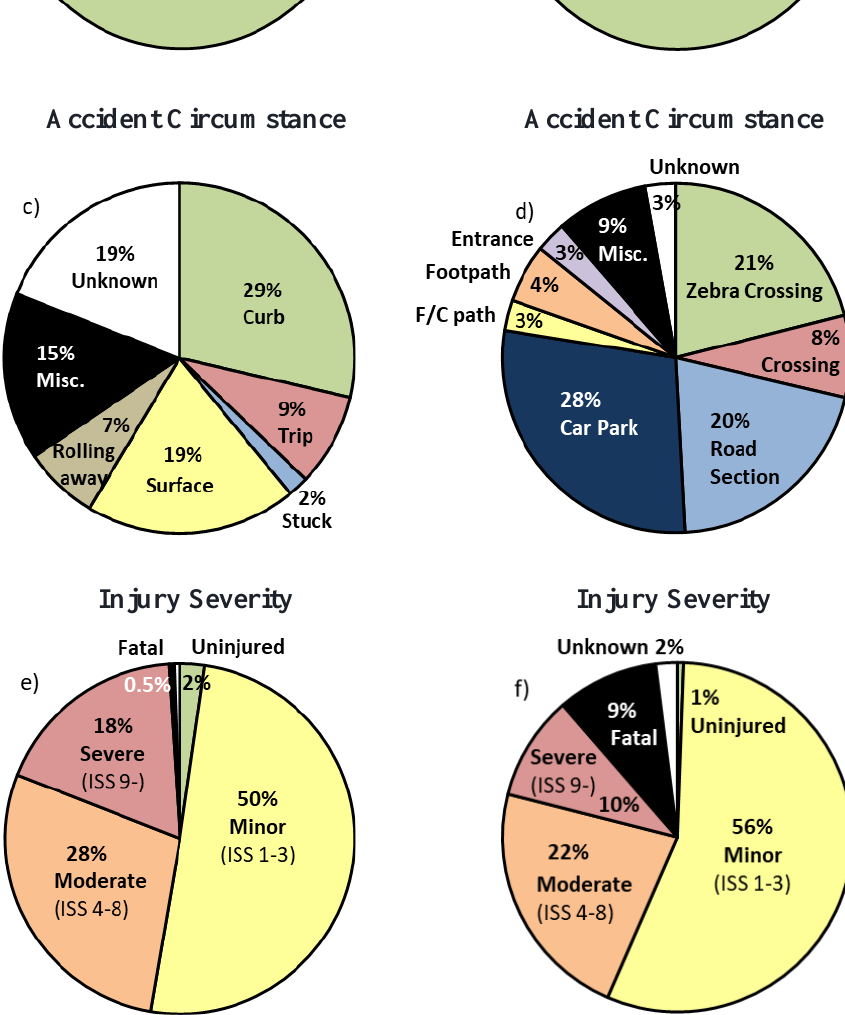
Figure 4. a) Single and b) collision accident events; c) single and d) collision